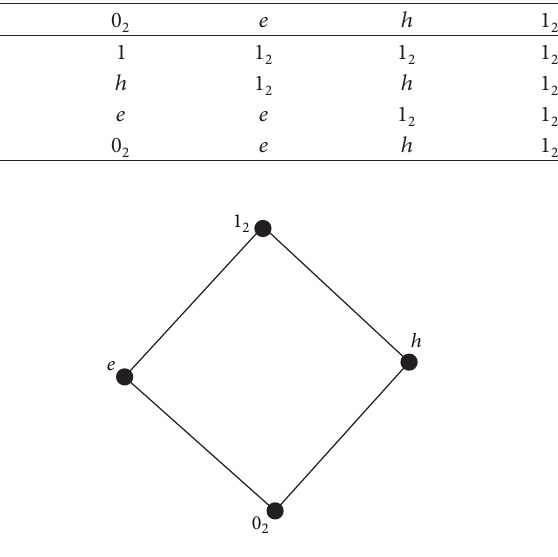
Figure 2: Hasse diagram of 𝐿 2 = {0 2 ,𝑒,ℎ,1 2 }